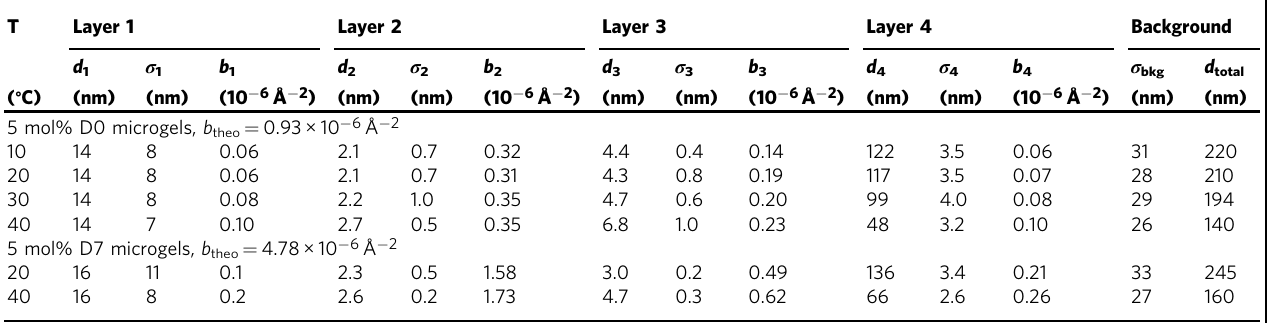
Table 2 Parameters of the 4-layers fi t for the 5% mol% cross-linked microgels in Fig. 1. T Layer